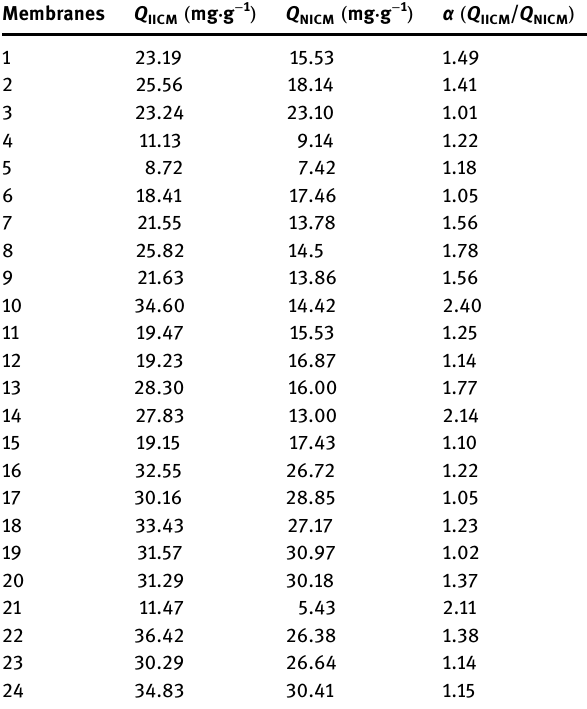
Table 2: Adsorption properties of membranes